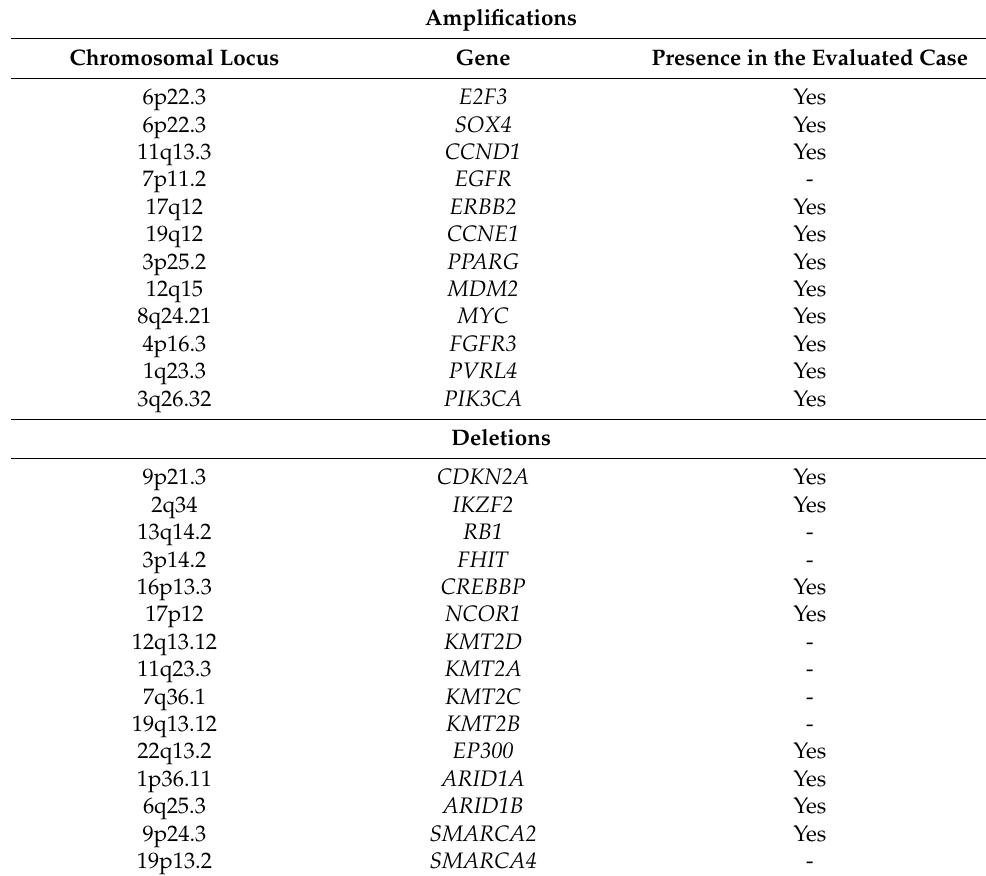
Table 1. Most frequent amplifications and deletions, observed in the bladder cancer, and their presence in the described